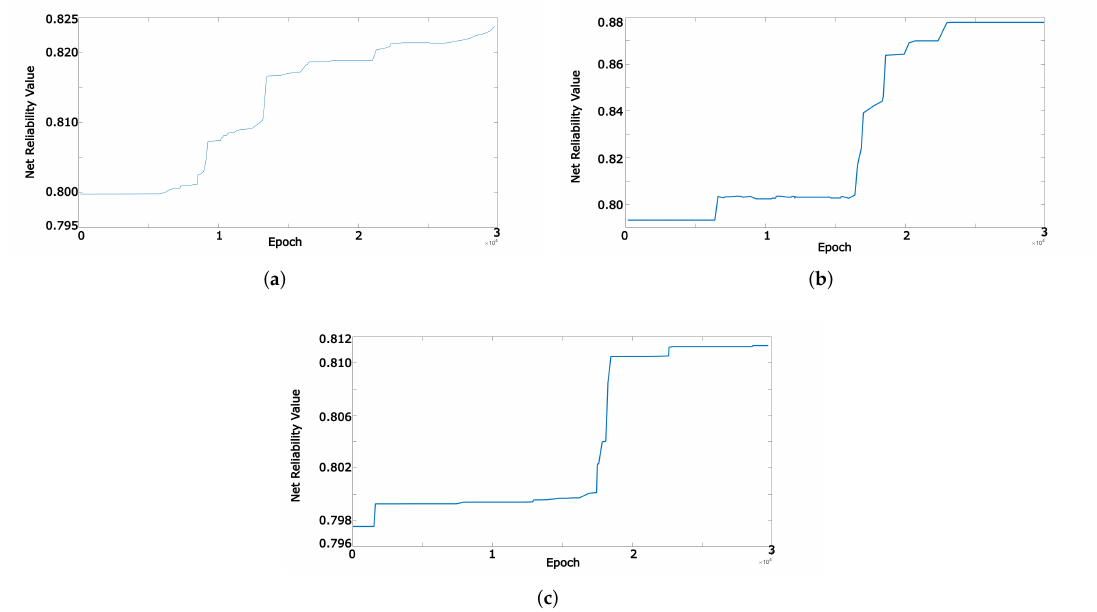
Figure 7. event OS value evaluation. ( a ) Event 1 (i.e., Accident); ( b ) Event 2 (i.e., Traffic); ( c ) Event 3 (i.e., Road